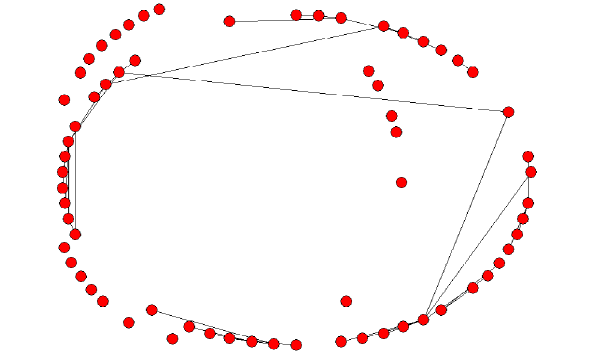
Figure 2: Communicative Network